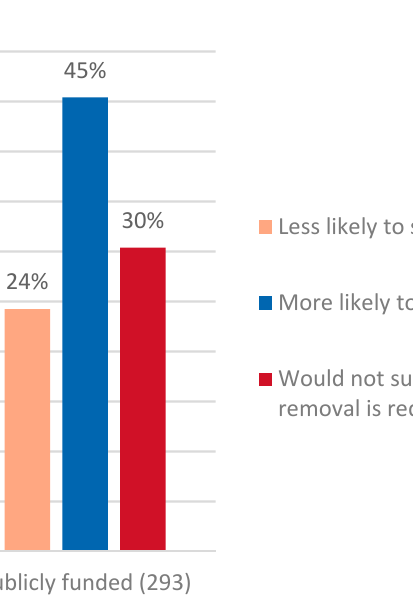
Figure 4. Financial Factors Influencing Support.